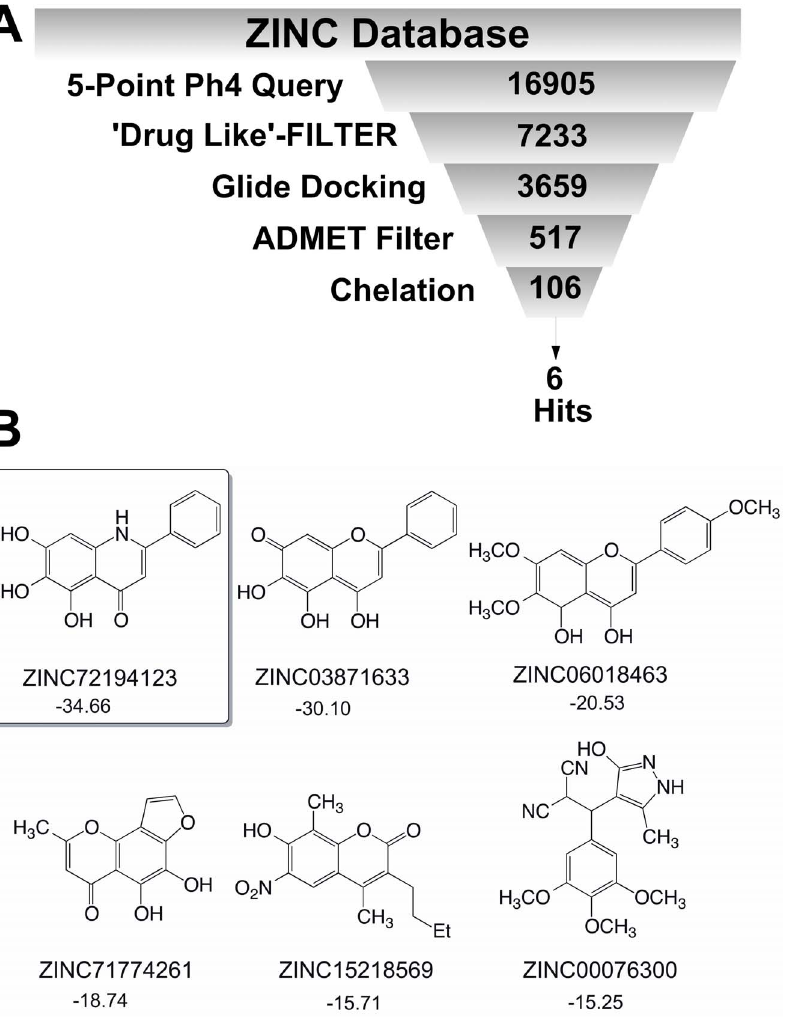
Figure 6. Models to identification. A. Virtual screening workflow; B. 2D representation of Hits obtained from the virtual screening process is shown with ZINC ID and chelation energy in kcal/mol.